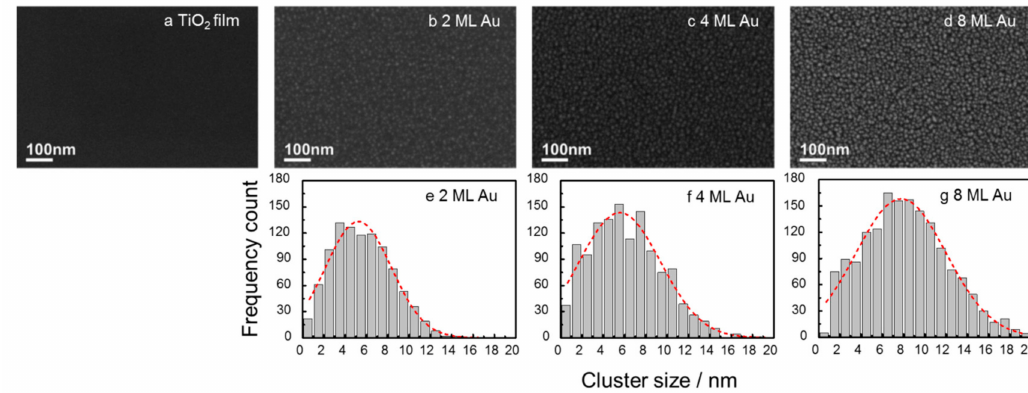
Figure 1. SEM images of Si wafers supported TiO 2 P25 ( a ). Gas phase Au cluster modified TiO 2 P25 films with 2 ML ( b ), 4 ML ( c ) and 8 ML ( d ) equivalent coverage as well as size distribution histograms of 2 ML ( e ), 4 ML ( f ) and 8 ML ( g ) samples. The red dash lines in the histograms are the fittings of cluster distributions.